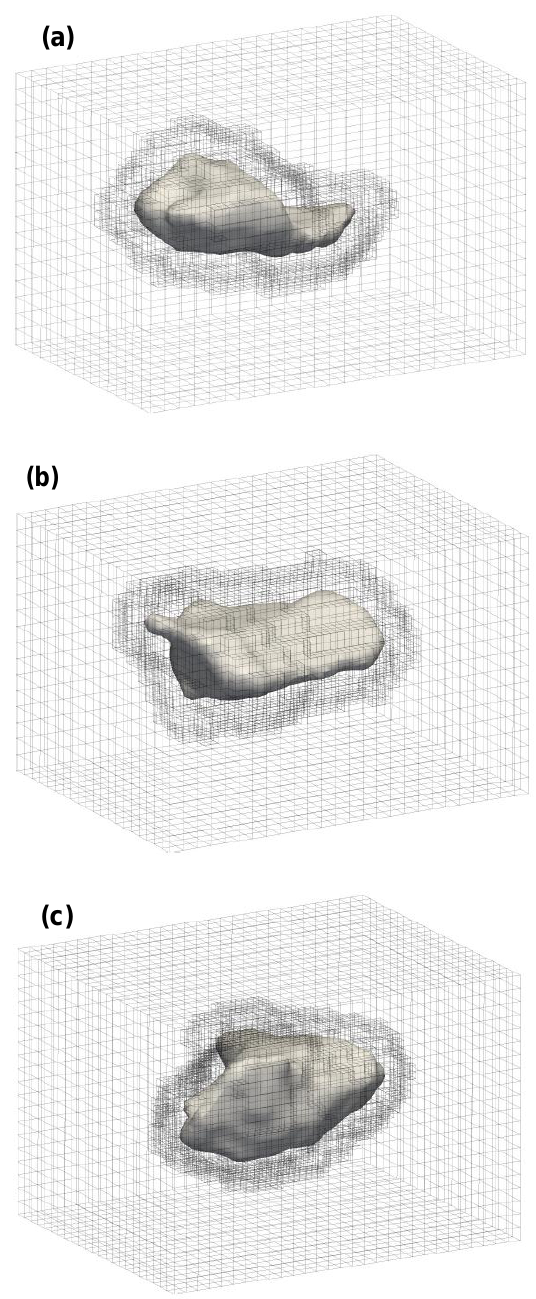
Figure 10. Particle geometries in mesh wireframe that are used in history plot of fracture probability ( a ) Particle-m, ( b ) Particle-n, and ( c ) Particle-p. Rigid body motions are fixed.and traction is applied on both left and right